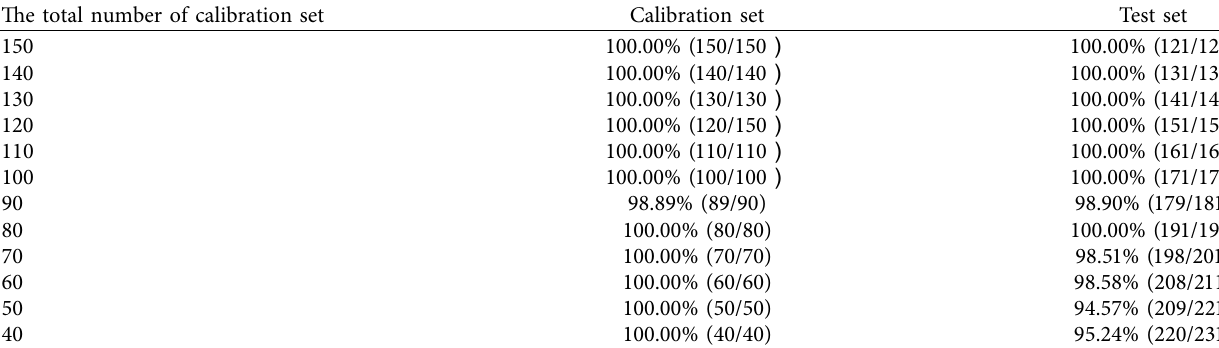
Table 4: The classification results of the calibration set and the test set based on the different number of samples in the calibration set by convolutional neural network.